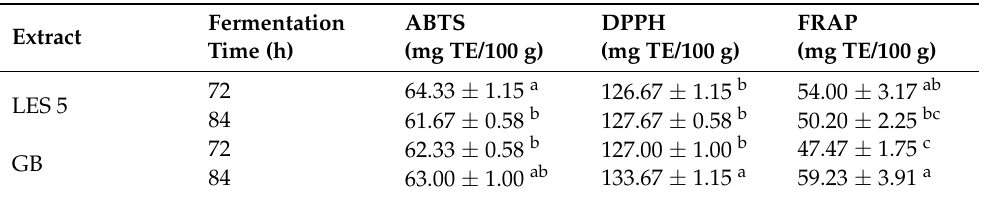
Table 5. Antioxidant activities of fermentative extracts of two sorghum genotypes, LES 5 and GB, determined by the ABTS, DPPH, and FRAP